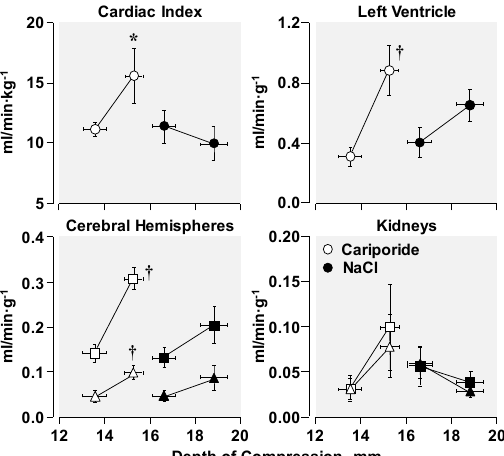
Figure 4. Leftward shift of the flow-depth relationship during chest compression elicited by cariporide in rats during VF. Rats were randomized to receive a bolus of cariporide or NaCl before starting chest compression. The first symbol represents data from series 1 and the second symbol from series 2. For paired organs, triangles denote right and squares left. Values are mean ± SEM; * p < 0.05 vs. NaCl by one-way ANOVA in series 2; † p < 0.01 vs. series 1 within each treatment group by one-way ANOVA (Adapted with permission from Kolarova et al. [5]).